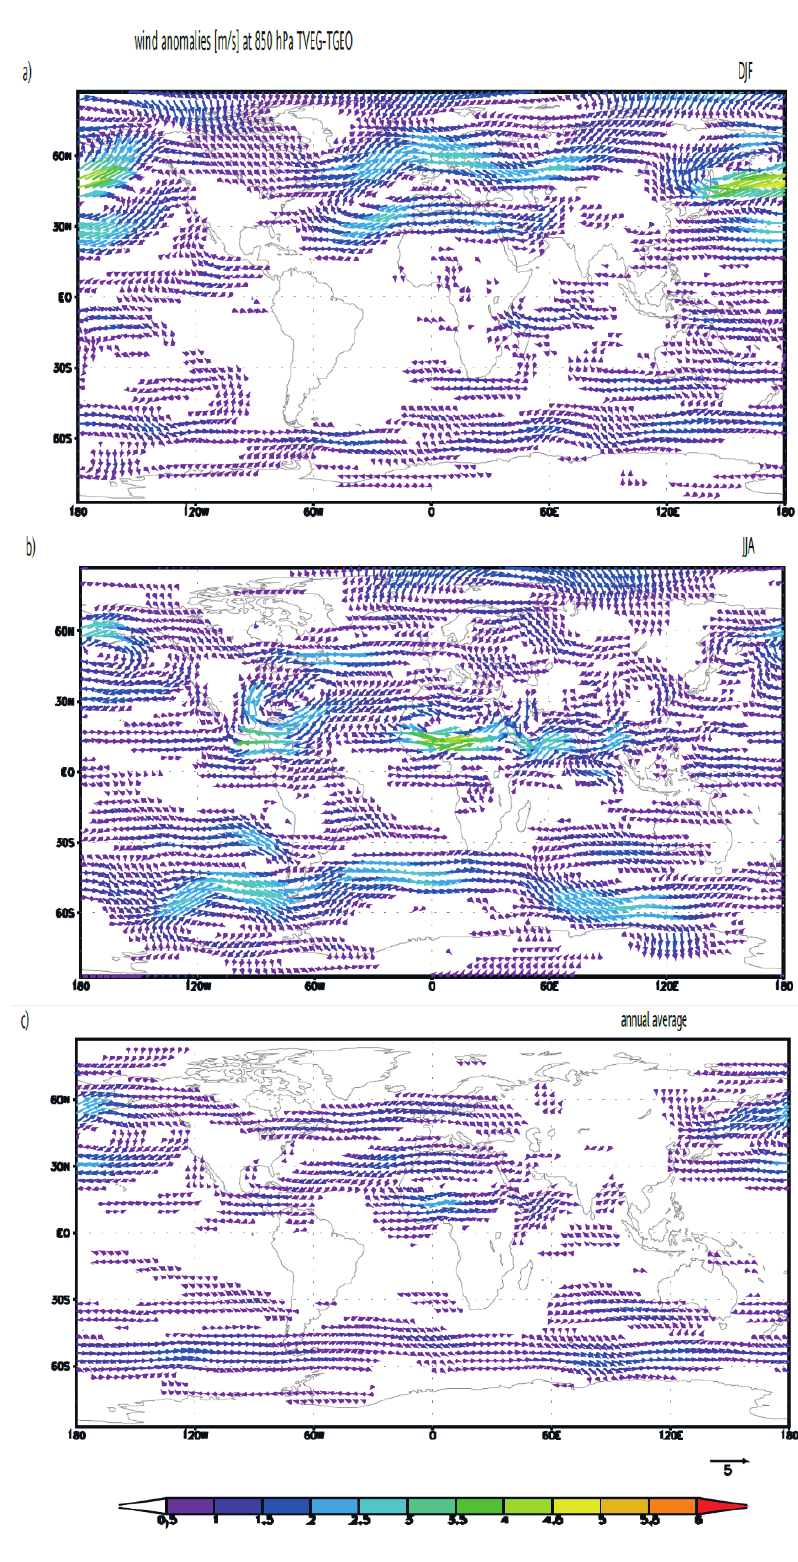
Figure 5. Changes in the wind field (m/s) at 850 hPa for TVEG minus TGEO. ( a ) Boreal winter: December-January-February; ( b ) boreal summer: June-July-August; ( c ) annual mean. The reference arrow represents 5 m/s. Vectors for differences of less than 0.5 m/s are not